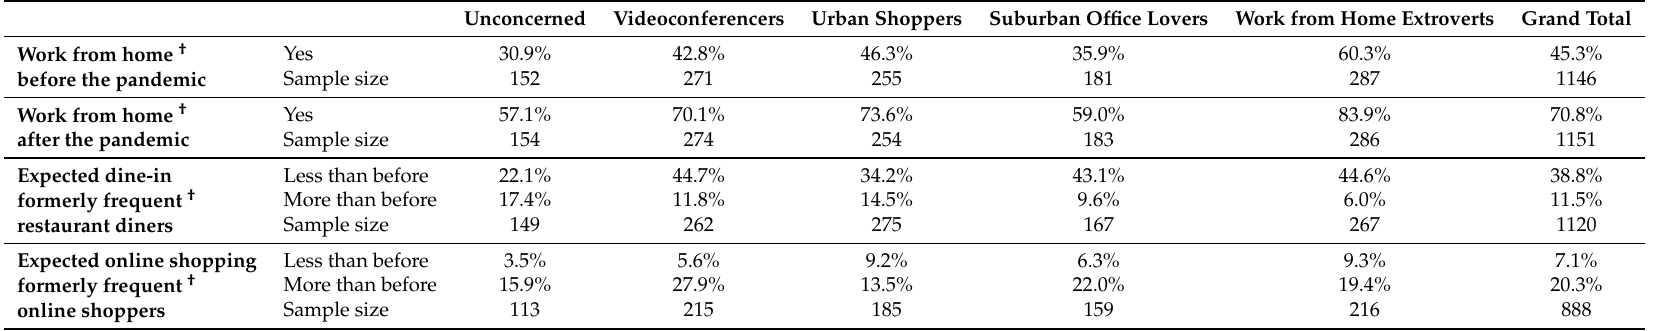
Table 6. Expected change in work from home, shopping and dining frequencies, by attitudinal typology. Unconcerned Videoconferencers Urban Shoppers